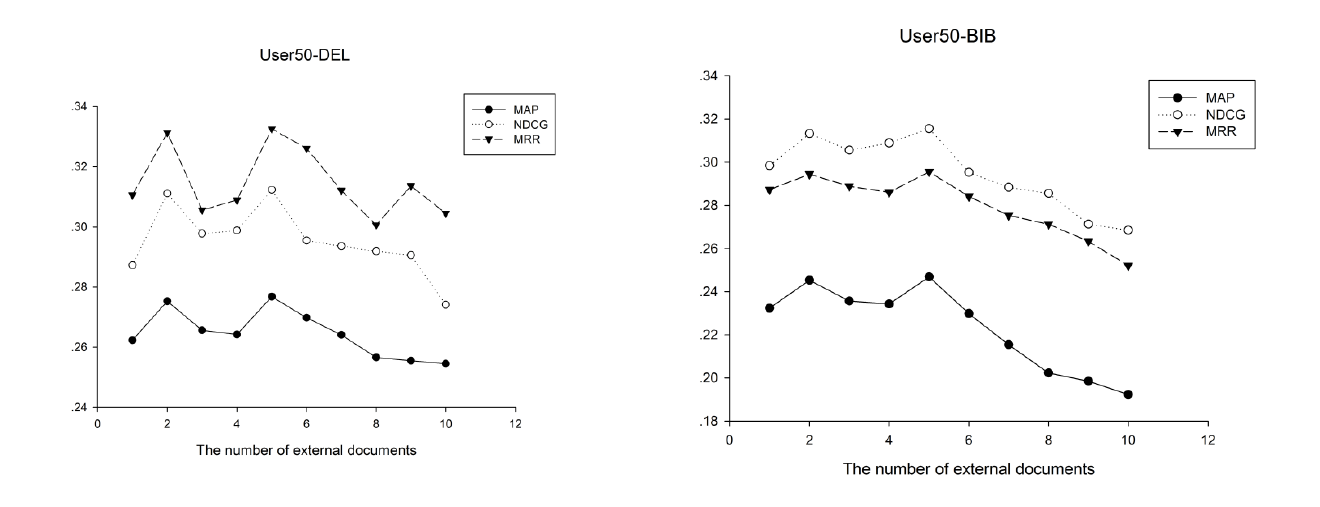
Fig. 5 . The performance by varying the number of external documents on two corpora